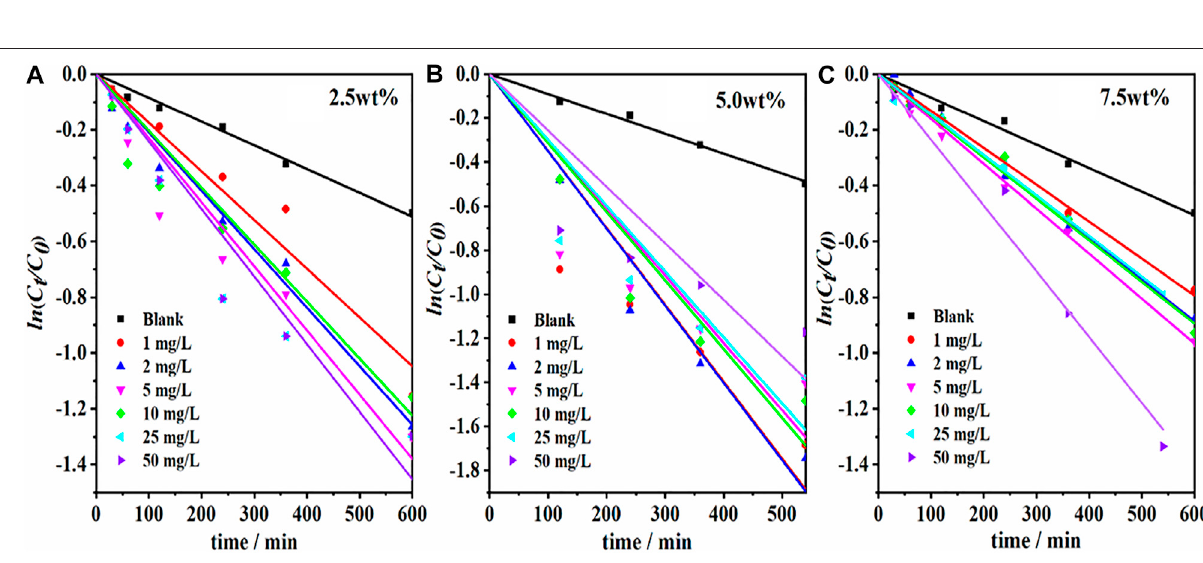
Frontiers in Chemistry |